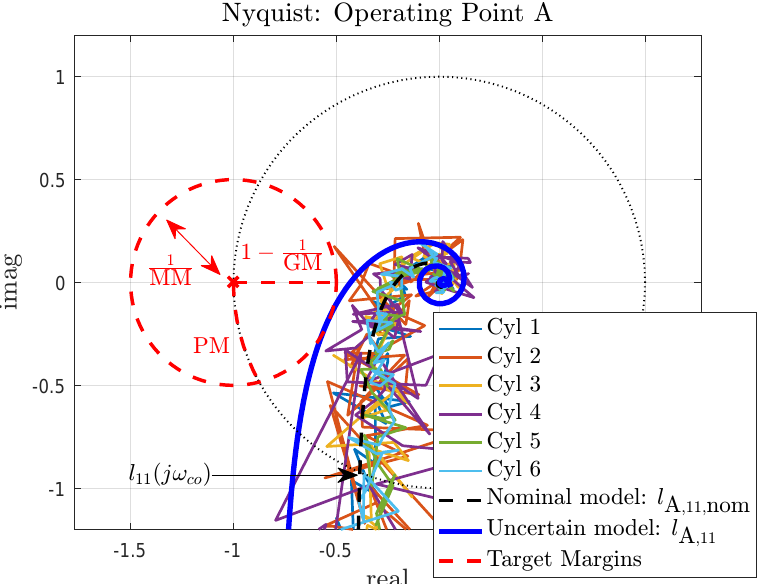
Figure 7. Nyquist plot of loop gain l A,11 for six individual cylinders (operating point